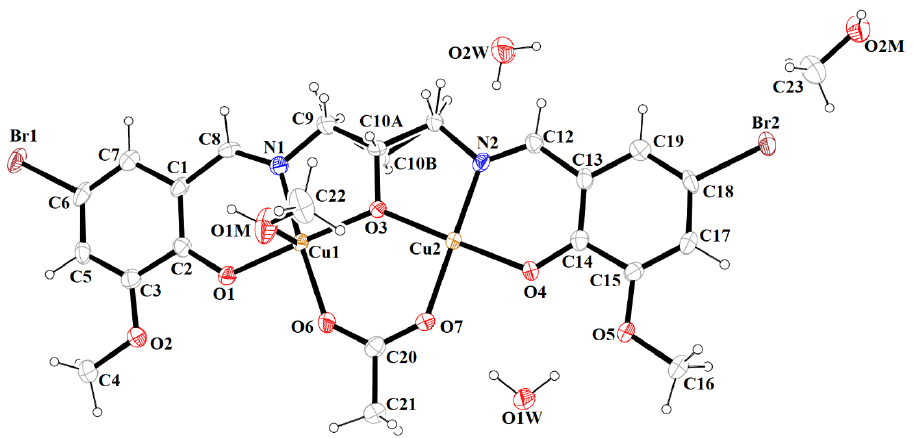
Figure 5. Molecular structure and numbering atoms scheme of 2. Displacement ellipsoids are drawn at the 60% probability level.